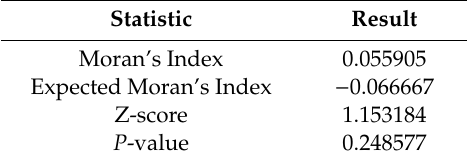
Table 4. Results of the significance test based on Moran’s I .